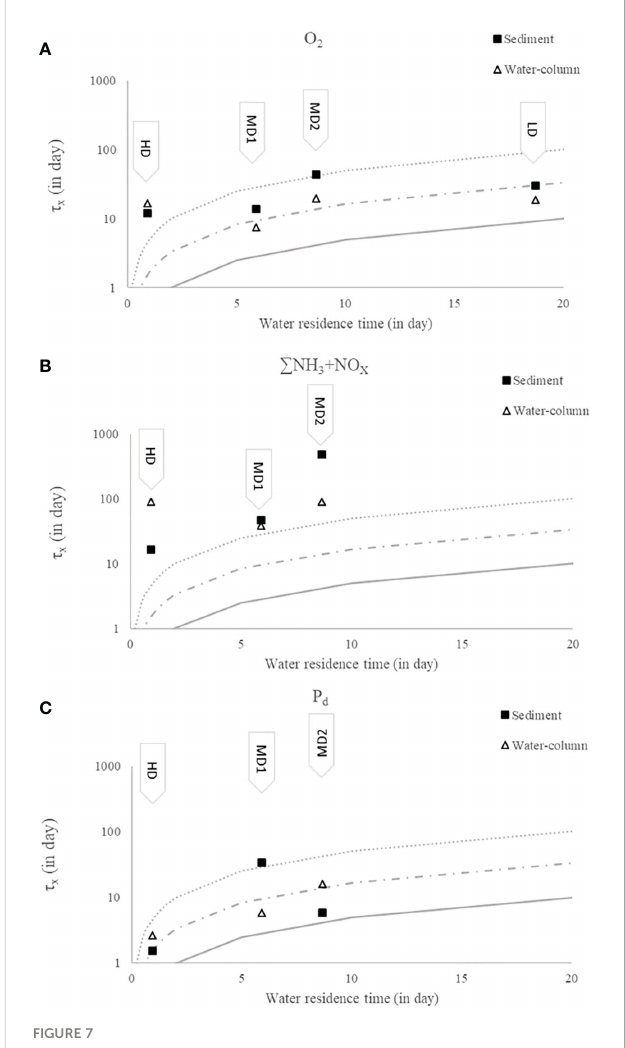
FIGURE 7 Characteristic residence time ( t x ) of oxygen (A) , nitrogen species (B) , and dissolved phosphorus (C) calculated from benthic fl ux (dark square) and pelagic organic matter reactivity (empty triangles) as a function of estuarine water residence time. Dotted line indicates the arbitrary limit of signi fi cance of reactive processes, i.e., t sed = ½*1/ 0.1* T residence , which indicates a very low contribution above this line (below 10% of initial stock was affected by fl ux during estuarine transfer). Continuous line indicates predominance of reactivity over the upstream endmember to control species concentrations, i.e., t sed/water, x = ½ *1* T residence . It indicates that below the dark line, water concentration changes by more than 100% during estuarine transfer. Dotted – dashed line indicates an intermediate situation, i.e., t sed/water, x = ½ *1/0.3* T residence with 30% of water concentration